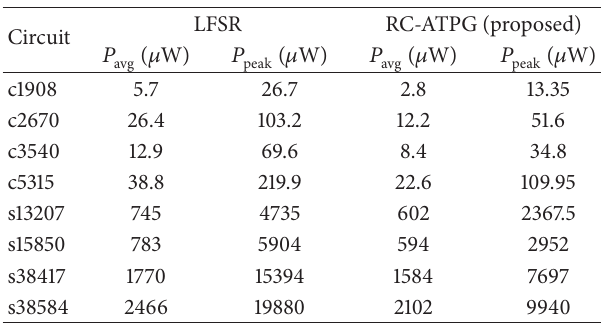
Table 3: Power reduction for ISCAS benchmarks.